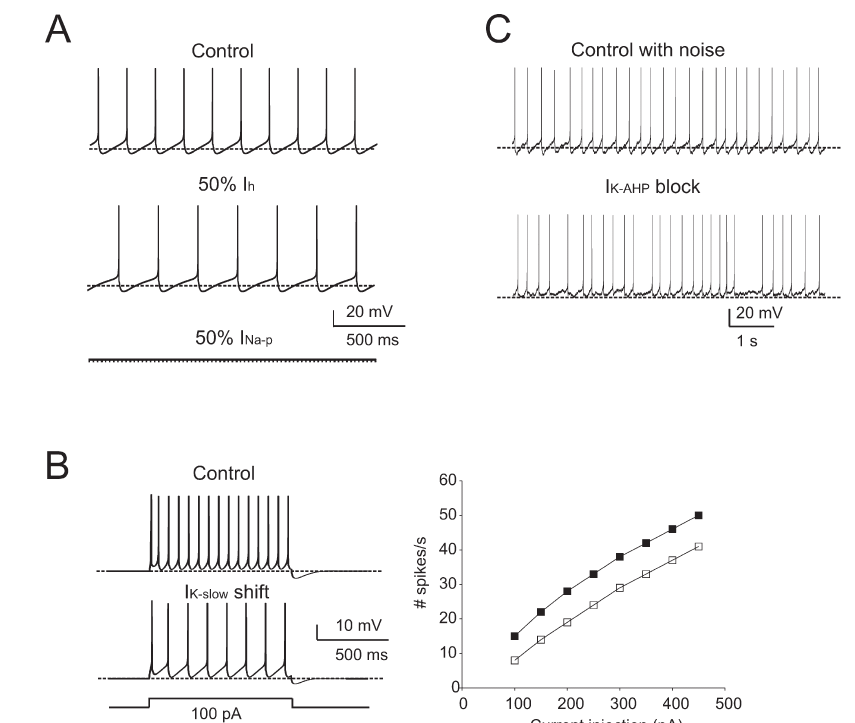
Figure 5. Pharmacology of pacemaking . The model predicted the effect of ionic channel blockage (Forti et al., 2006) on autorhythmic firing. ( A ) In these simulations, the control trace shows autorhythmic firing (same as in Figure 1A , firing rate 5Hz, CV ISI ¼ 0.0027), a 50% block of I h (mimicking the effect of ZD7288) reduces the pacemaker frequency by 27%, and the partial block of I Na-p prevents spontaneous firing. ( B ) In order to simulate retigabine effects on I K-slow reported by Forti et al., (2006), I K-slow was modified by shifting its activation by (cid:1) 6.5mV (from Tatulian et al., 2001). The model was then stimulated with 1-second current steps (100pA) from -70mV. The traces show that, following I K-slow changes, the model fires less action potentials than in control. The model response to current injection is shown for control (full squares) and I K-slow -shift conditions (empty squares). ( C ) The effect of membrane noise on firing was simulated by injecting Gaussian noise into the canonical model. In control conditions, the mean firing rate was unaffected, but CV ISI was increased from 0.002 to 0.16. When I K- AHP was blocked, the mean firing rate did not significantly change (from 5 to 5.7Hz, p > 0.05, t-test). Conversely, CV ISI changed from 0.16 to 0.36 (cf. Forti et al., 2006). The traces show that pacemaker irregularity is markedly increased by I K-AHP blockage (the dashed lines indicate the (cid:1) 70mV level)